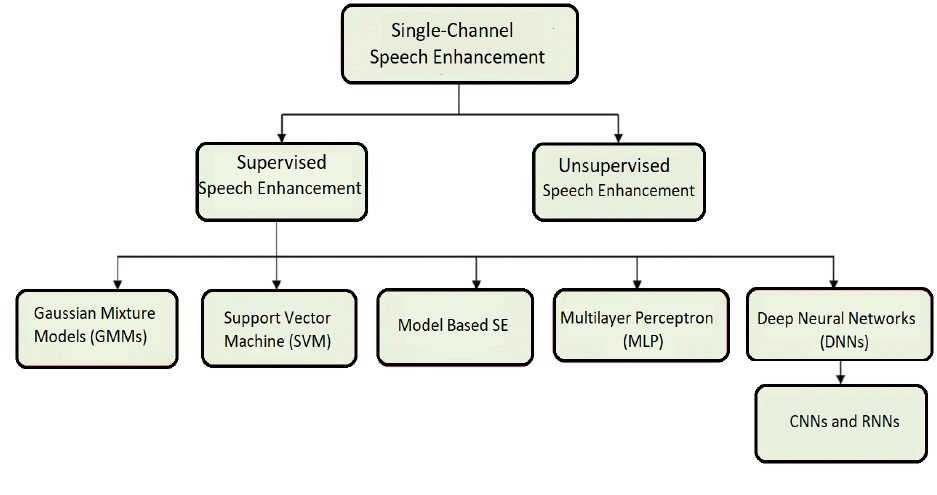
Figure 1. The overall speech enhancement research work highlighting the flow of the